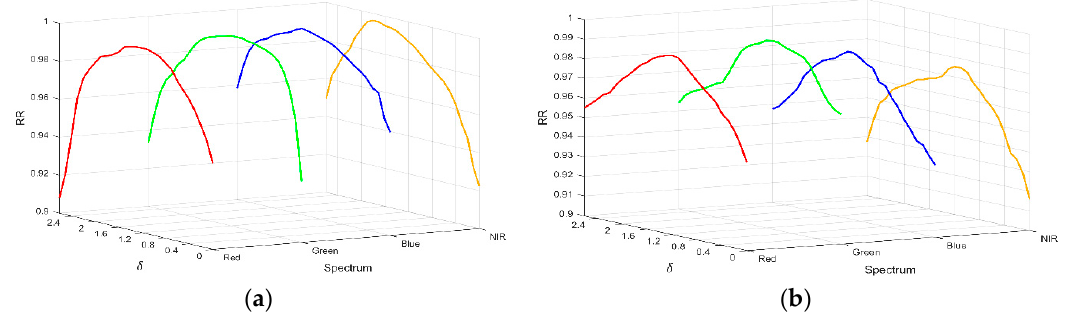
Figure 12. Recognition rates (RR) with different acutance TPVA on a single band of HPV with different local texture patterns. Results using the feature extraction methods of ( a ) CompCode; ( b ) deep features.